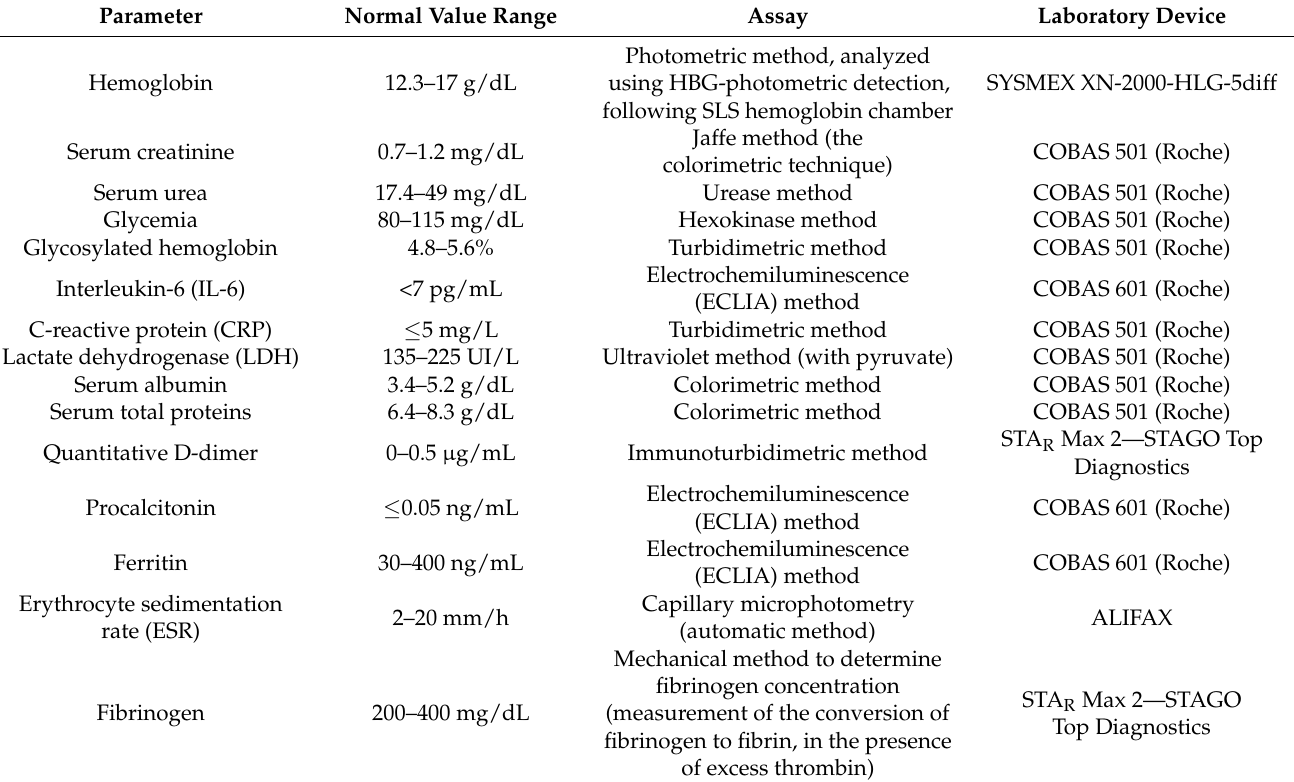
Table 1. Assessed parameters at the time of admission (performed method and laboratory